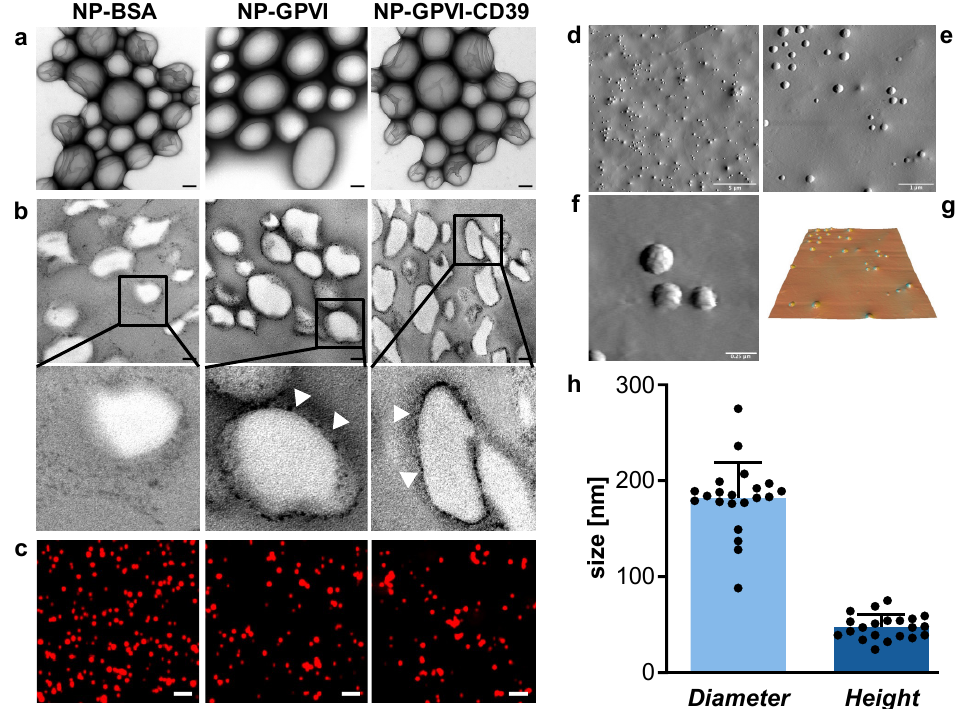
Figure 3. Morphological characterization of the nanoparticles ( a , b ) Electron microscopic display of nanoparticles, ( a ) negative staining, scale 100 nm, ( b ) ultra-thin sectioning, scale 100 nm, illustrates the coating differences amongst the nanoparticles. NP-GPVI and NP-GPVI-CD39 display their functional coating proteins as a distinctive surface coating pattern (arrowheads). ( c ) confocal laser scanning microscopy of fluorescent nanoparticles, scale 2 μ m. ( d–f ): Topographical portrayal of NP-BSA through atomic force microscopy (AFM) in increasing magnification; ( d ) scale bar = 5 μ m, ( e ) scale bar = 1 μ m, (f ) scale bar = 0.25 μ m, ( g ) three-dimensional transformation of ( e ), ( h ) Quantitative analysis of the morphology parameters diameter and height, based on AFM measurements. Mean ± SD, n = 21.